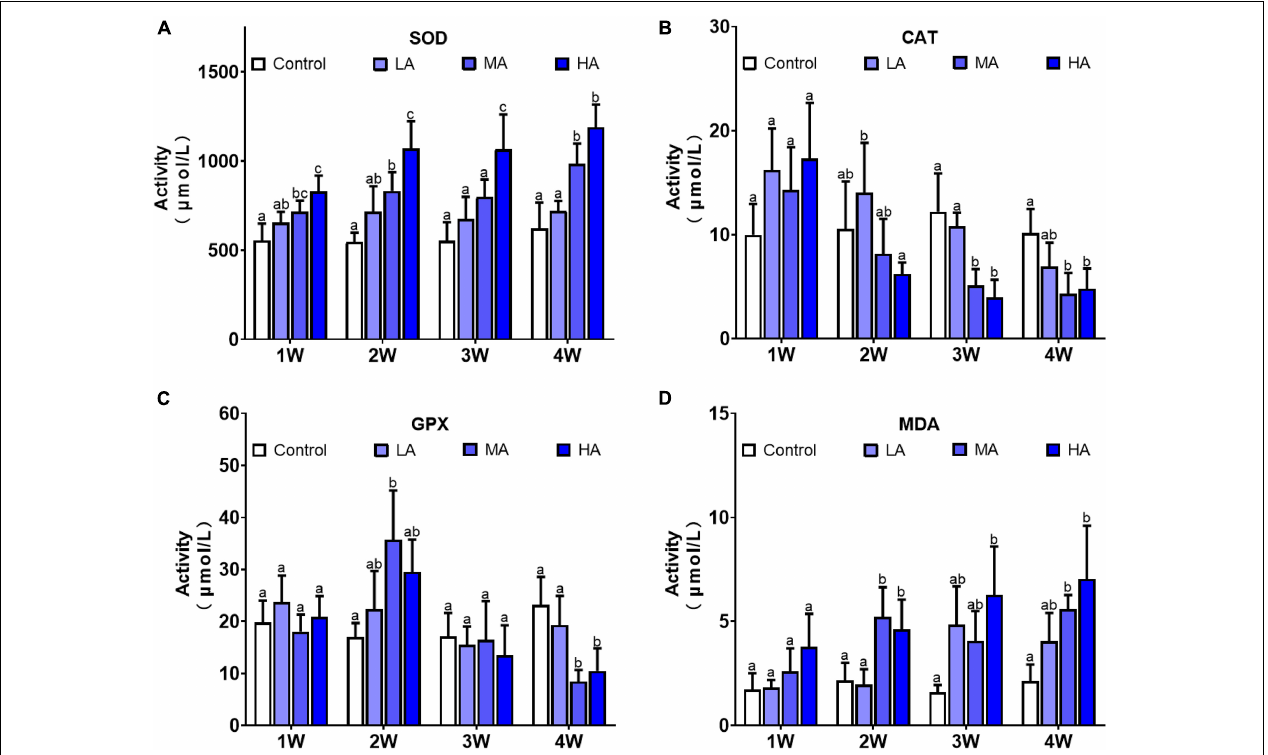
FIGURE 4 | Activities of SOD (A) , CAT (B) , GPX (C) , and levels of MDA (D) in different treatments during long-term ammonia stress. Values are means ± S.D ( n = 3). Different letters represent significant differences among different groups ( P < 0.05).